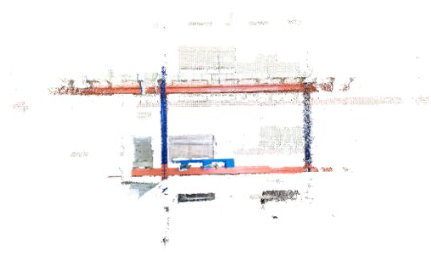
Figure 14. Shelf scene point cloud.